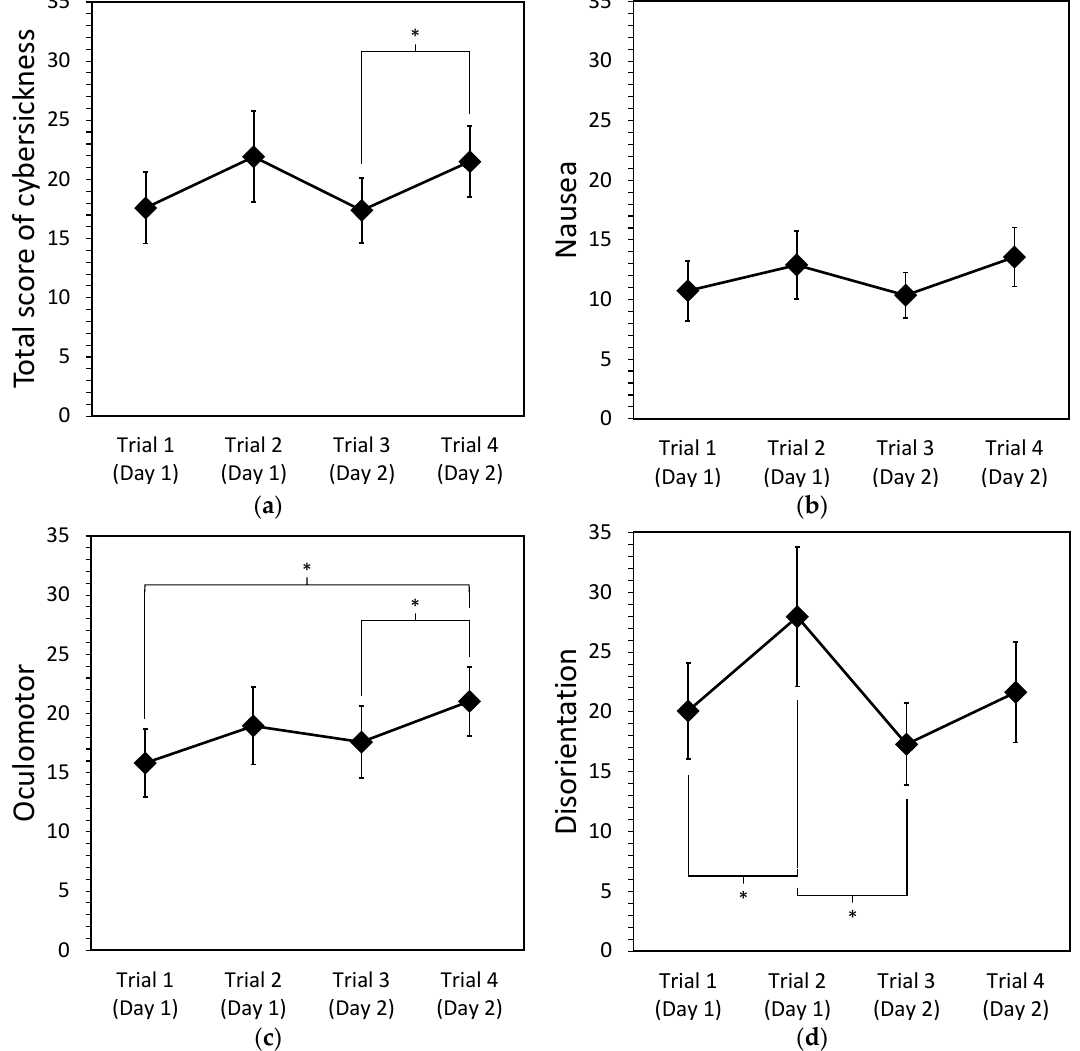
Figure 6. Plot of mean SSQ scores for cybersickness and its symptoms per trial: ( a ) total score of cybersickness; ( b ) nausea; ( c ) oculomotor; ( d ) disorientation. The error bars represent 95% confidence intervals for each condition. The * represents p < 0.05 for the statistical significance.